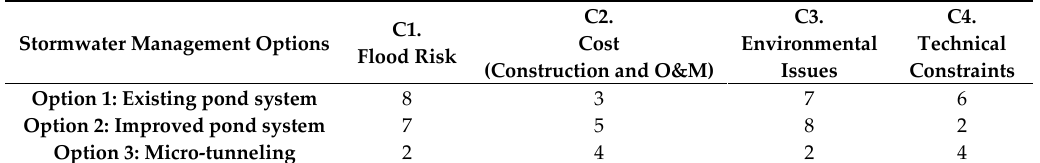
Table 7. Decision matrix for evaluation of stormwater drainage options.